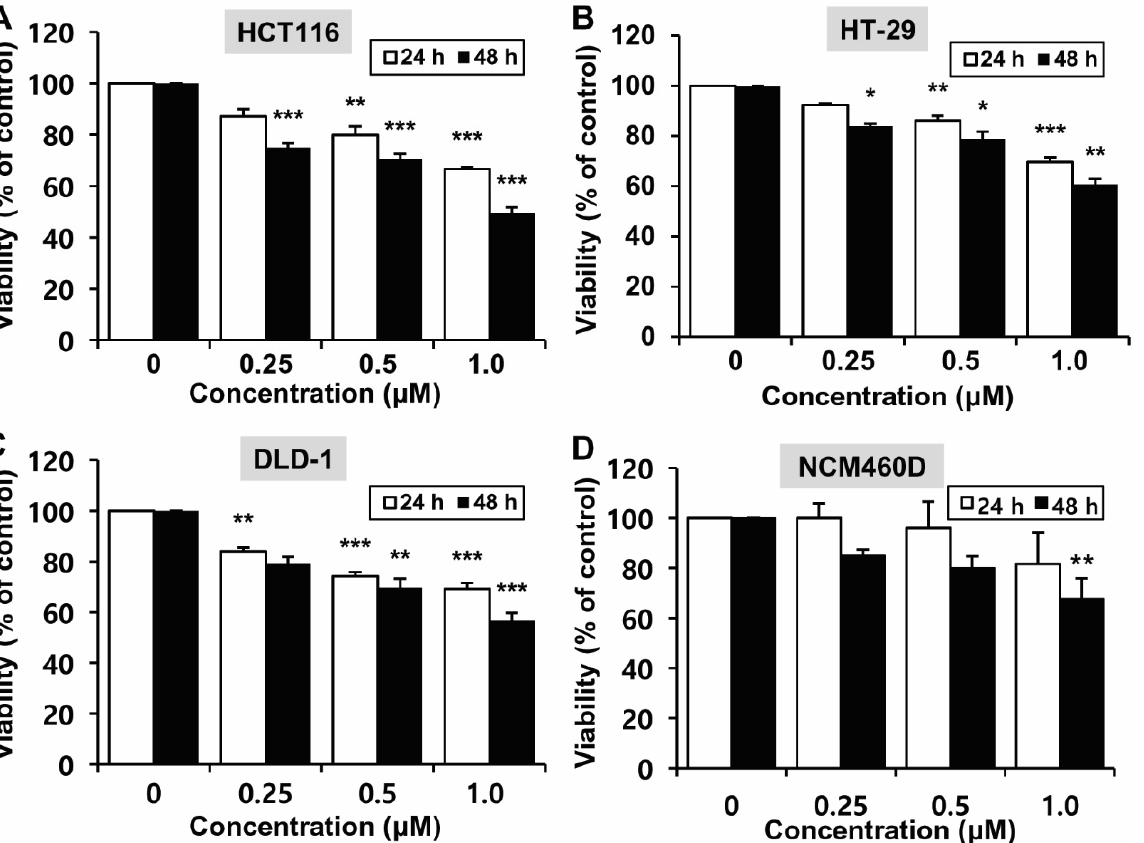
Figure 2. Effect of MHY2245 on the viability of the human colorectal cancer cell lines HCT116, HT-29, and DLD-1, and the normal human colon epithelial cell line, NCM460D. Graphs showing the viability of HCT116 ( A ), HT-29 ( B ), DLD-1 ( C ), and NCM460D ( D ) cells treated with increasing concentrations of MHY2245 for 24 h and 48 h. Results are presented as mean ± standard deviation (SD), n = 3, and are expressed as a percentage of viability in vehicle-treated control cells. * p < 0.05, ** p < 0.01, and *** p < 0.001 compared with vehicle ‐ treated control cells.